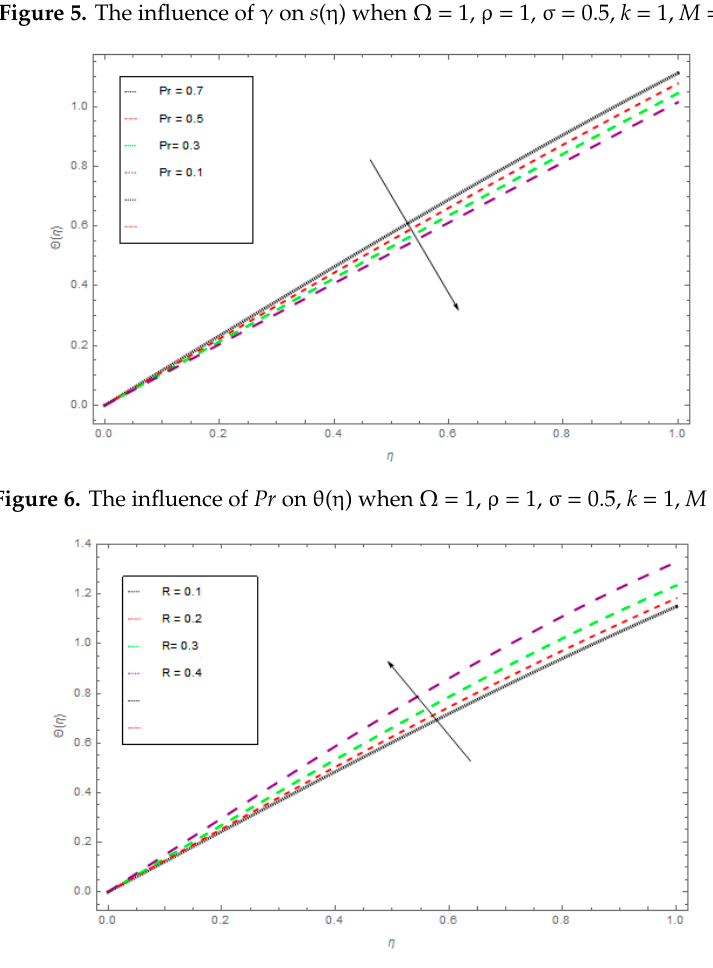
Figure 7. The influence of R on θ ( η ) when Ω = 1, ρ = 1, σ = 0.5, k = 1, M = 1.